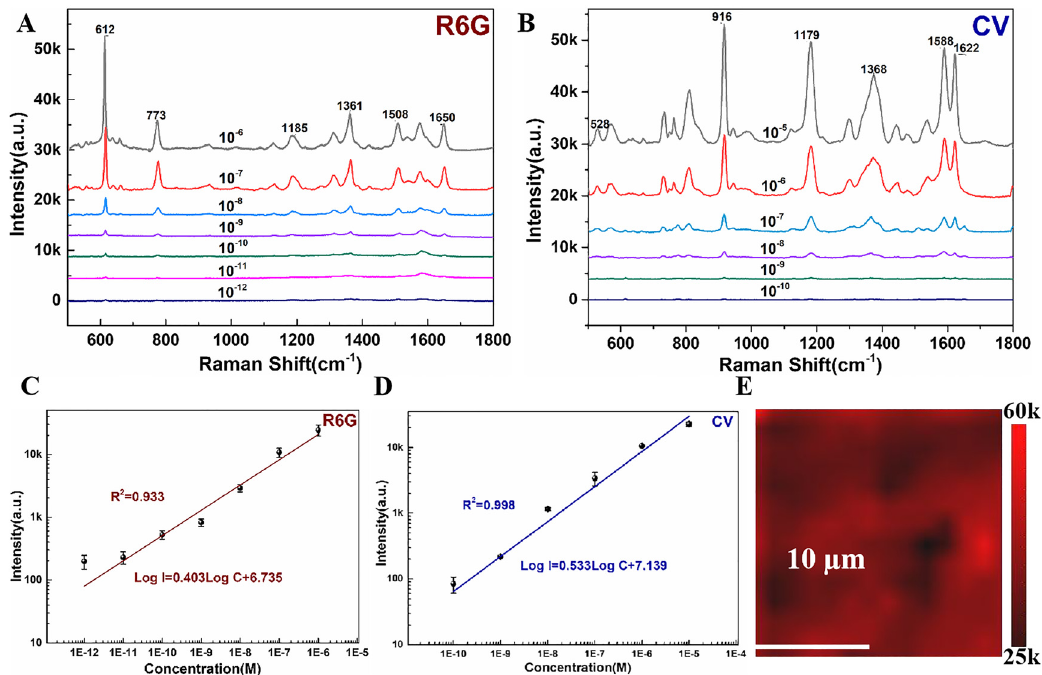
Figure5: (A) Surface-enhancedRamanspectroscopy (SERS)spectraof R6Gwith varyingconcentrations rangingfrom 10 − 6 to10 − 12 M. (B)SERS spectraof CV with varyingconcentrations rangingfrom 10 − 5 to 10 − 10 M.(C) Log − log plot of averageintensityof SERSsignalsat 612 cm − 1 versus the concentration of R6G. (D) Log − log plot of average intensity of SERS signals at 916 cm − 1 versus the concentration of CV. (E) Corresponding Raman mapping of the 612 cm − 1 characteristic peak of R6G (10 − 6